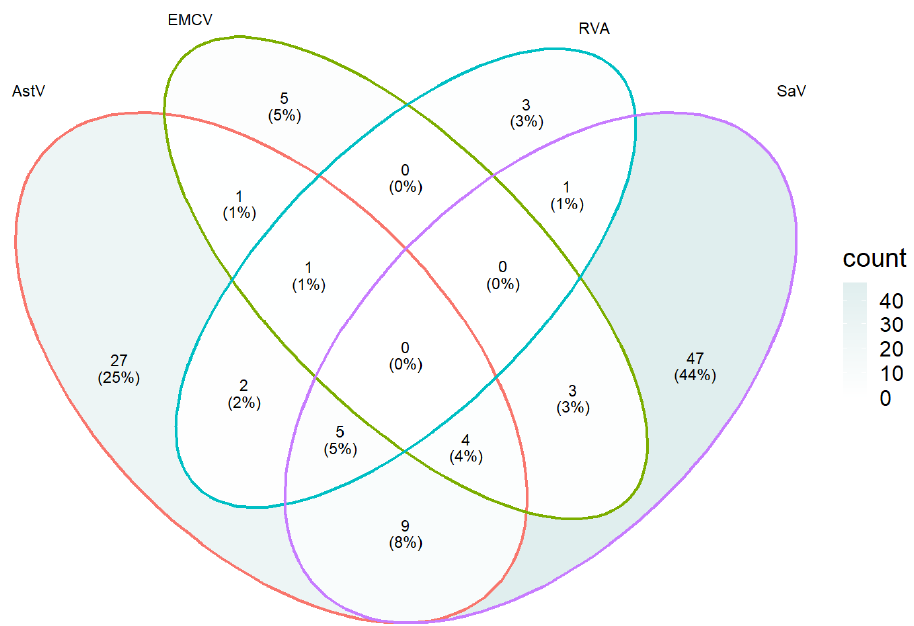
Figure 3. The number of single and mixed infections of Ast, EMCV, RVA and SaV. The coinfection rate of each virus was calculated using 100 samples that tested positive for at least one virus. For checking the reliability of the mRT-PCR assay, 130 samples containing 40 samples from diarrheic pigs were selected and further tested using sRT-PCR for SaV, EMCV, RVA and AstV. Except for SaV (Table 3), samples positive for each virus using sRT-PCR test also showed similar positive results when tested by mRT-PCR. Some of the mRT-PCR positive samples were also checked by sequencing. The concordance of sequence results were then checked by subjecting them to NCBI nucleotide blast and no false-positive results were